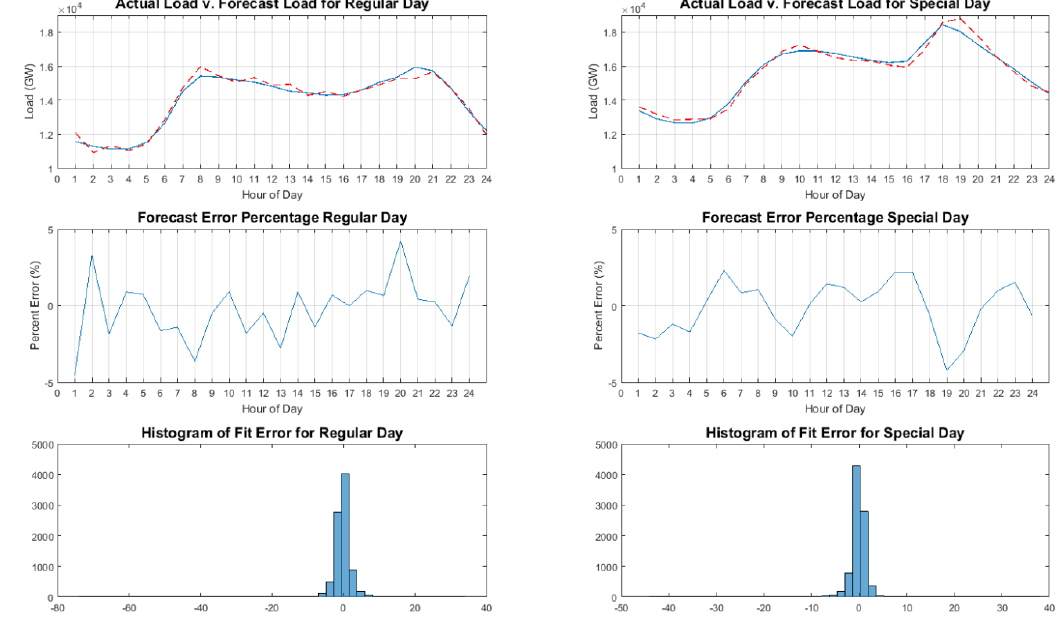
Figure 11. Comparison between results for regular vs. special